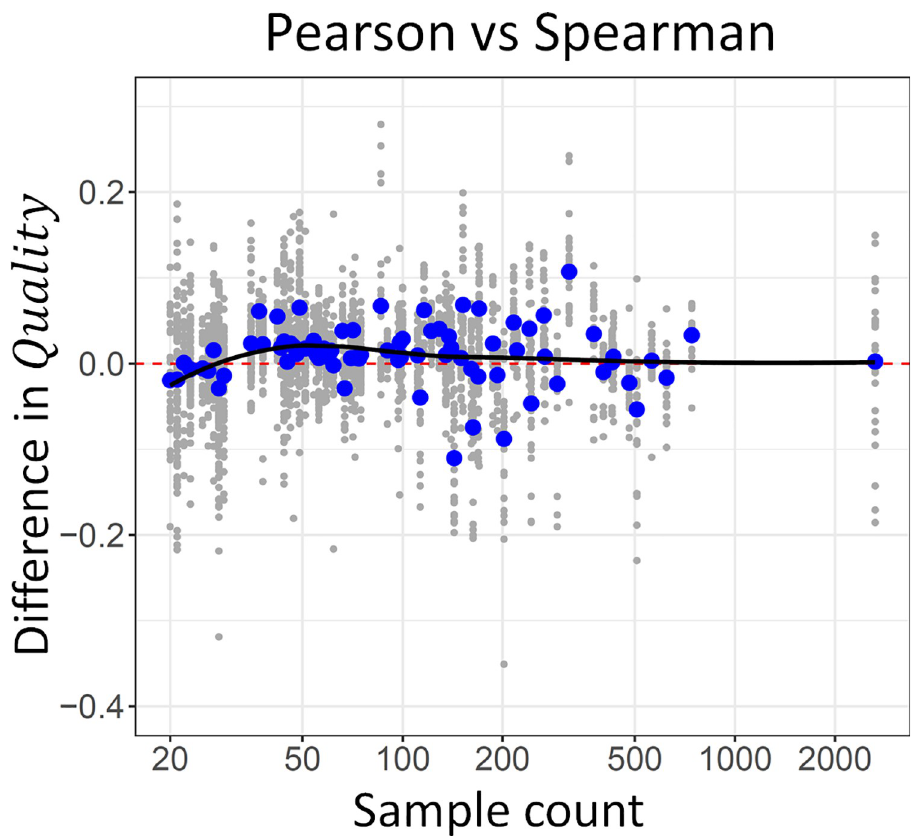
Fig 5. The preferred correlation measure depends on the number of samples. Difference in the quality of co- expression networks based on Pearson’s correlation and networks based on Spearman’s correlation is shown in function of the number of samples in the datasets. Positive values indicate an advantage for Pearson’s correlation. The average difference in quality is shown in blue for each dataset. A smoothed pattern (loess) is included in the